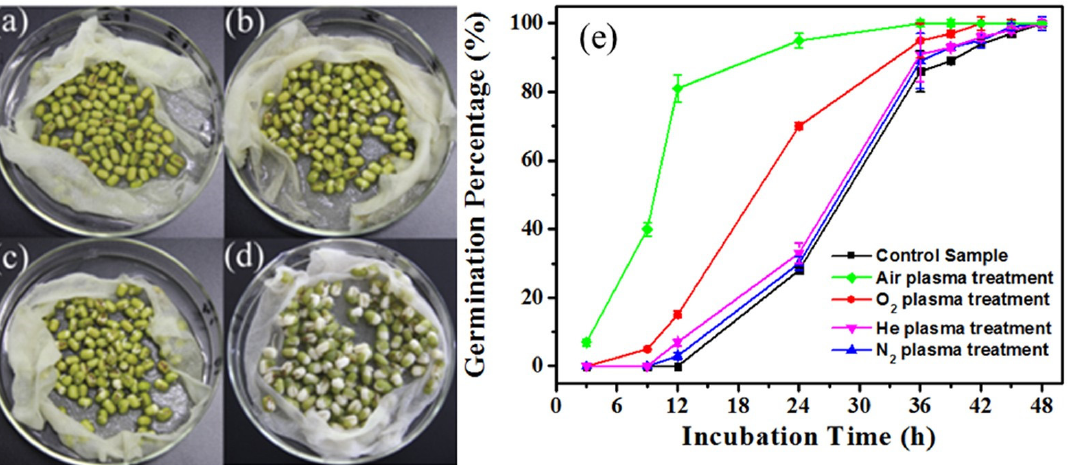
Figure 5. Air plasma drastically improved the germination rate of mung bean seeds. ( a ) 0 h, ( b ) 9 h, ( c ) 12 h, ( d ) 24 h, and ( e ) the germination percentage of mung bean seeds treated with He, N 2 , air, or O2 plasma as a function of incubation time [93].